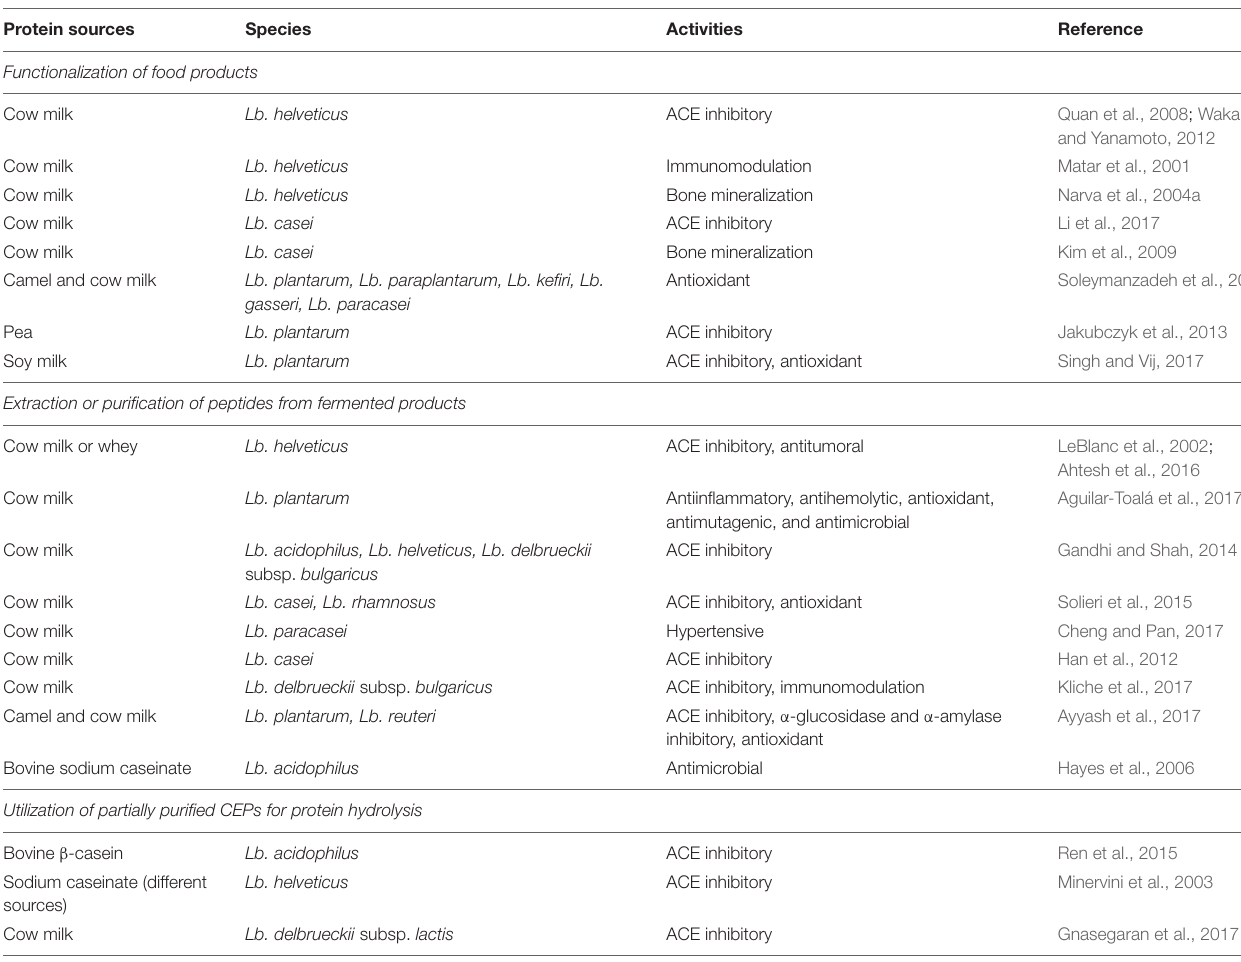
TABLE 2 | Applications of BAPs produced by Lactobacillus species depending on the production strategy. Protein